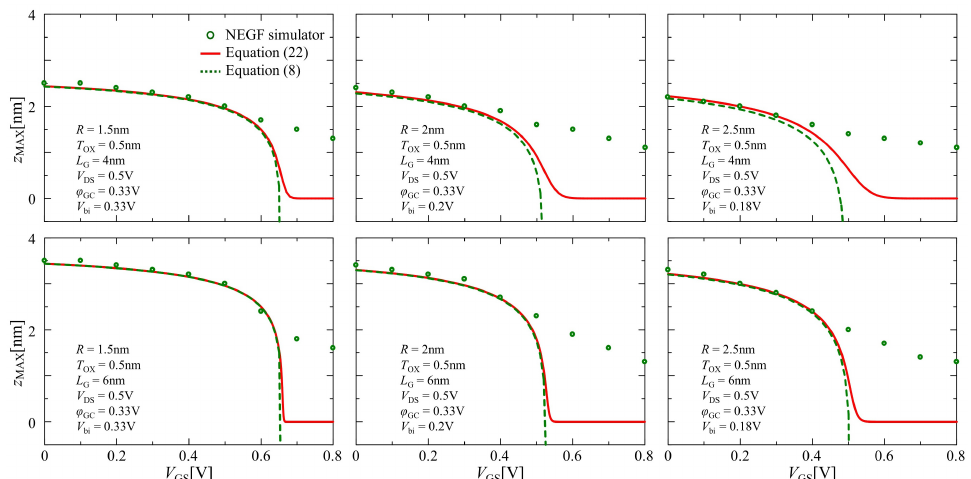
( 1 ) , ∆ U DIBL and ∆ U . G G G